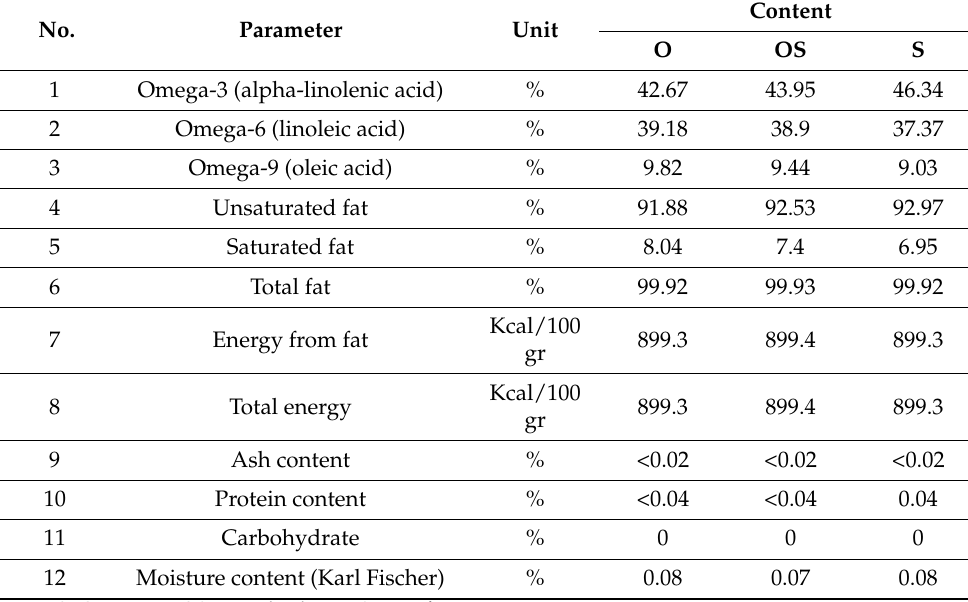
Table 5. Sacha Inchi oil content analyzed with the standard